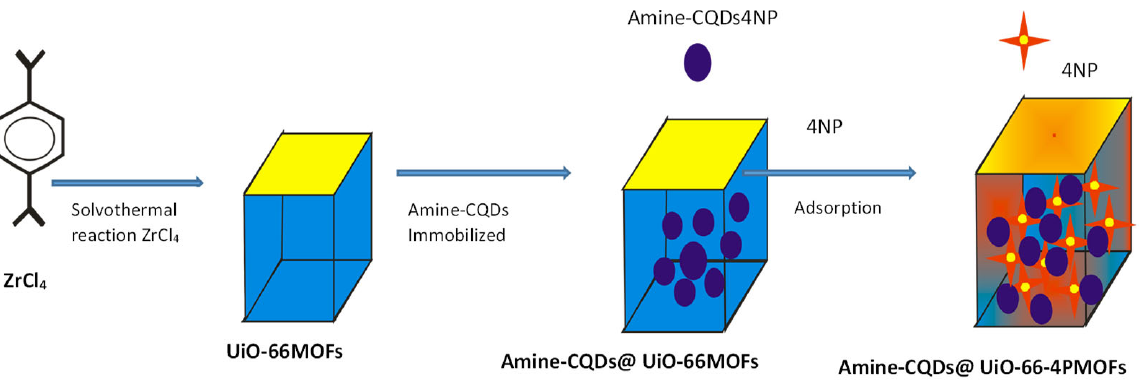
Figure 20. Synthesis of amine-CQDs@MOFs composite and its use as a sensor for